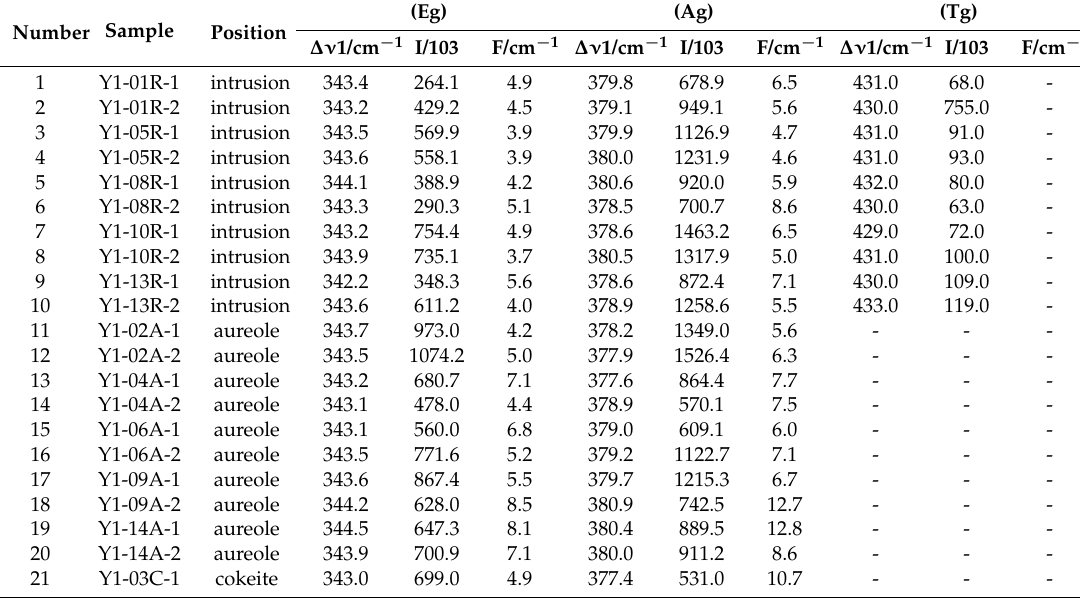
Table 1. Raman spectral data of